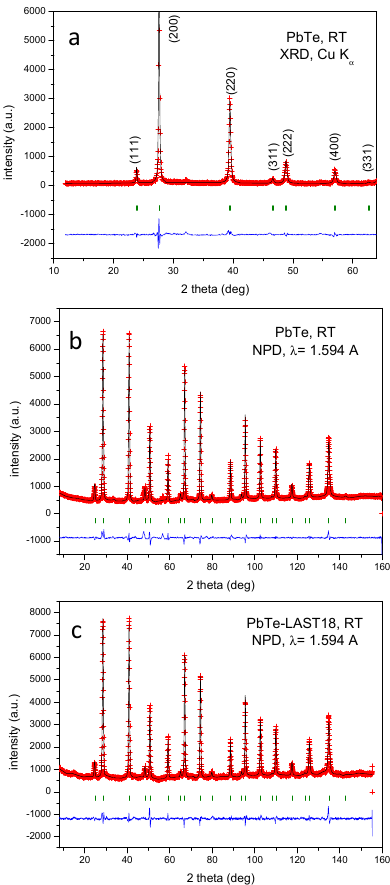
Figure 1. Observed (crosses), calculated (full line), and difference (at the bottom) profiles for ( a ) XRD pattern for as-grown PbTe, Rietveld-refined in the space group Fm-3m , ( b ) neutron powder diffraction (NPD) pattern for PbTe and ( c ) NPD patterns for PbTe-LAST18, at RT.